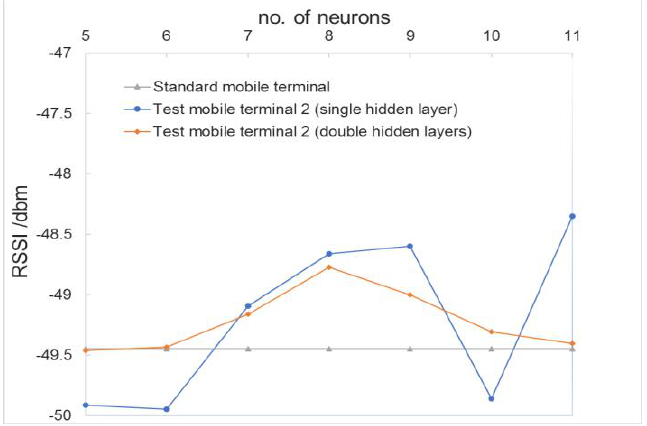
Figure 11. Comparison of the average RSSI value after calibration of test mobile terminal 2.